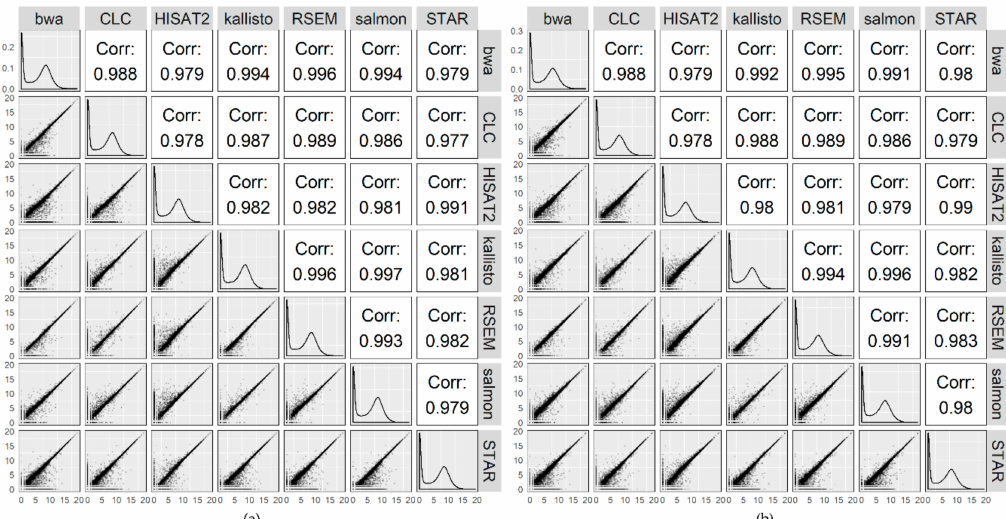
Figure 3. Raw counts of mapped reads determined by each mapper plotted against each other. Results are shown for sample A of Col-0 ( a ) and sample B of N14 ( b ) which both were obtained from plants grown under control conditions at 20 ◦ C (see Table A3 for sample information). Lower triangle represents scatterplots of log 2 (counts + 1) transformed, unfiltered raw counts for each mapper plotted against each other. The diagonal histograms show the density of the raw count distribution for each mapper. The upper triangle displays the correlation coe ffi